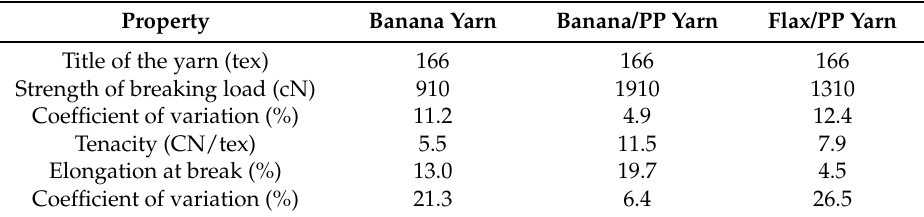
Table 8. Mechanical properties of